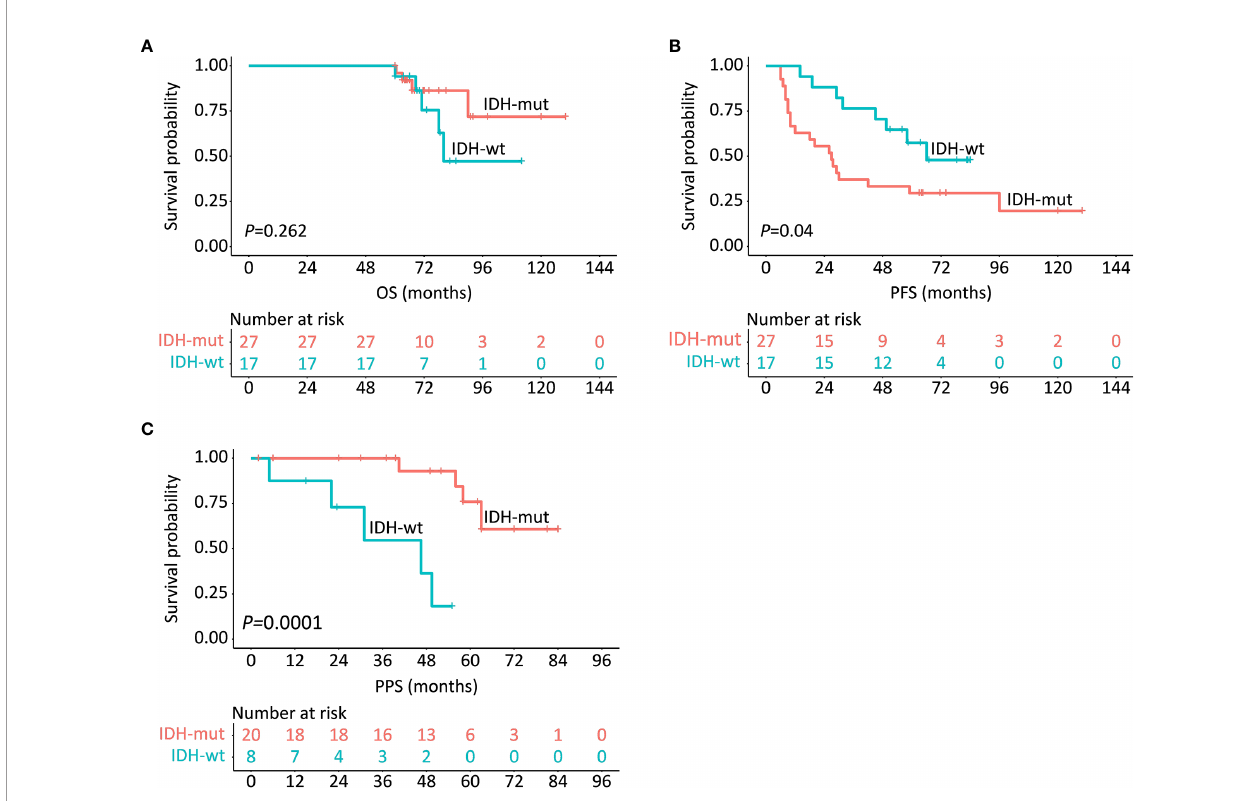
FIGURE 3 | Survival comparisons in regards to OS (A) , PFS (B) and PPS (C) between IDH-wt and IDH-mut